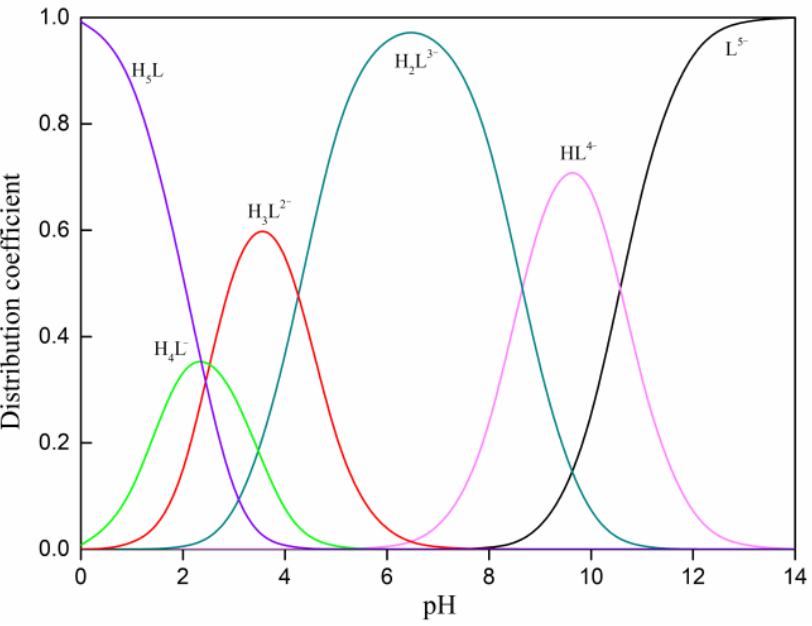
Figure 11. Distribution coefficients for the complexes of PD in aqueous solutions as a function of pH (ionization constant [53]: pK a1 = 2.06; pK a2 = 2.73; pK a3 = 4.28; pK a4 = 8.65; and pK a5 = 10.59).